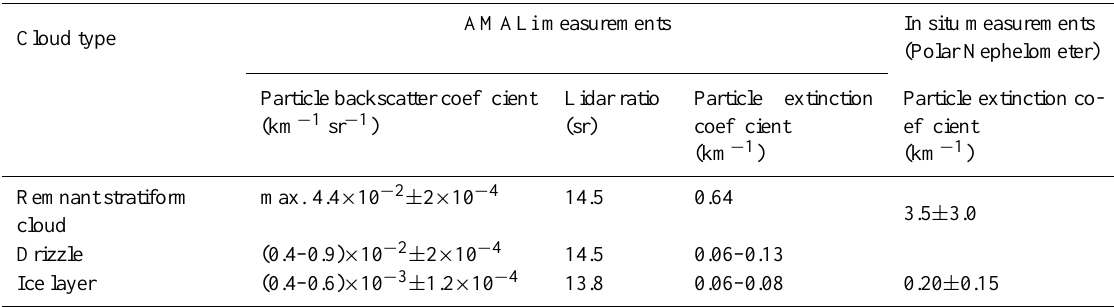
Table 1. Values of the particle backscatter and extinction coefficient with uncertainties (error discussion in text) retrieved from the AMALi observations in three different clouds. The values of the particle extinction coefficient and the lidar ratio derived from the Polar Nephelometer measurements (mean values and standard deviations) are also